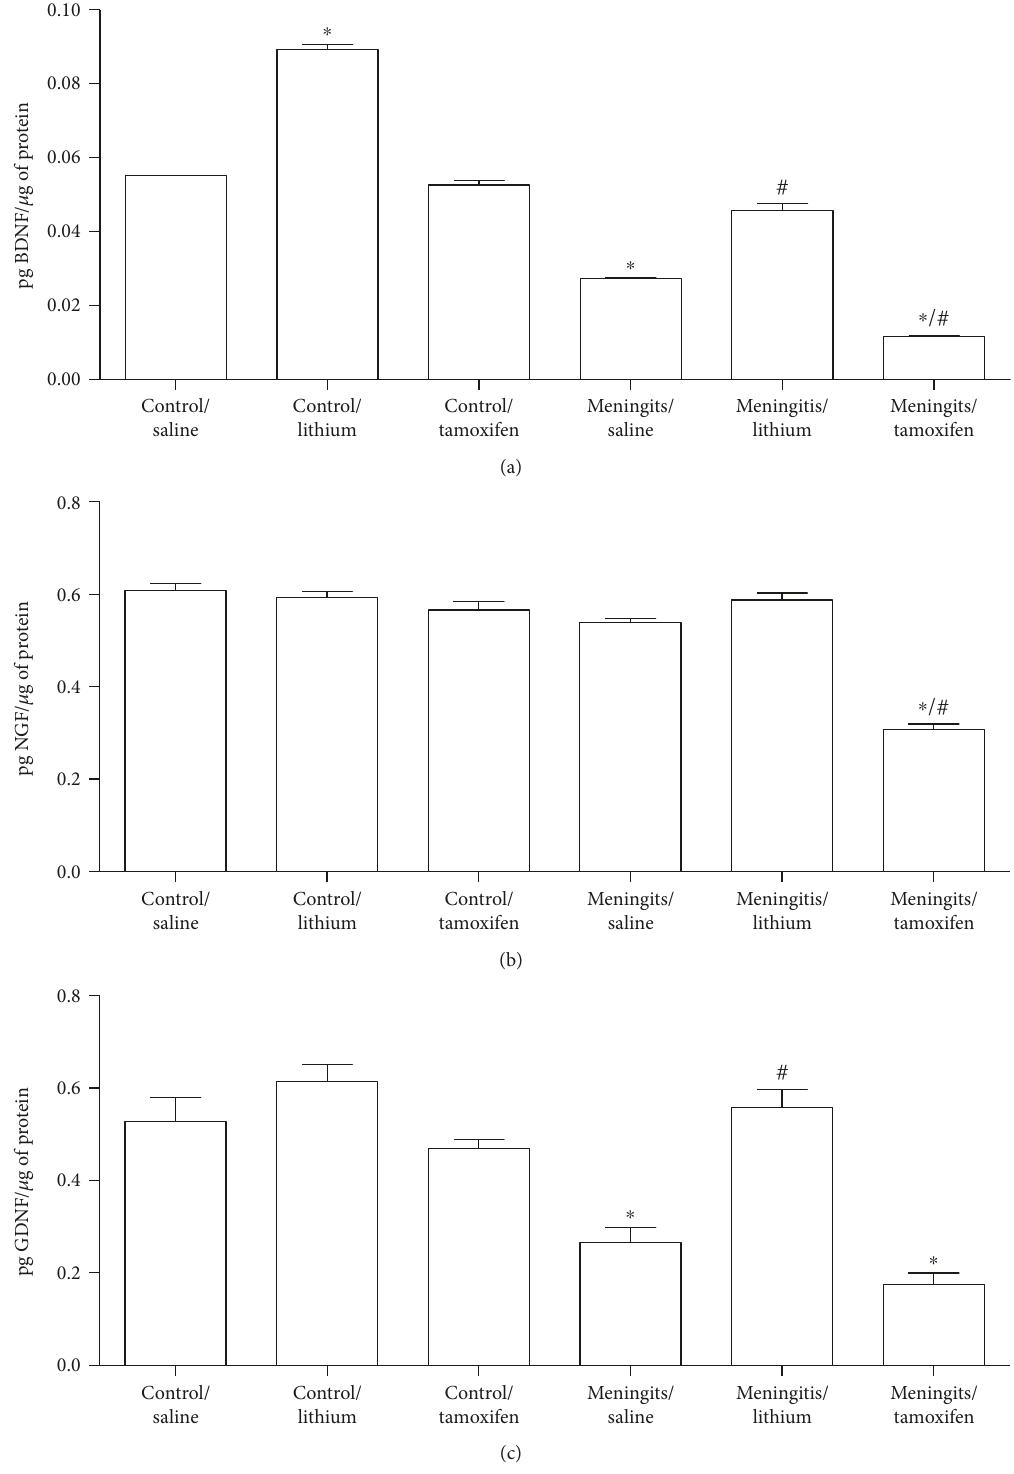
Figure 4: E ff ects of lithium and tamoxifen on BDNF, NGF, and GDNF expression in the hippocampus 10 days after pneumococcal meningitis induction. BDNF (a), NGF (b), and GDNF (c) levels were assessed by ELISA, and the results are presented in pg per μ g of protein, with n = 5 per group. All data are reported as the means ± SEM. These results were analyzed by two-way ANOVA, followed by the Tukey post hoc test. ∗ P < 0 05 indicates the statistical signi fi cance of the control/saline group and # P < 0 05 indicates the statistical signi fi cance of the meningitis/saline